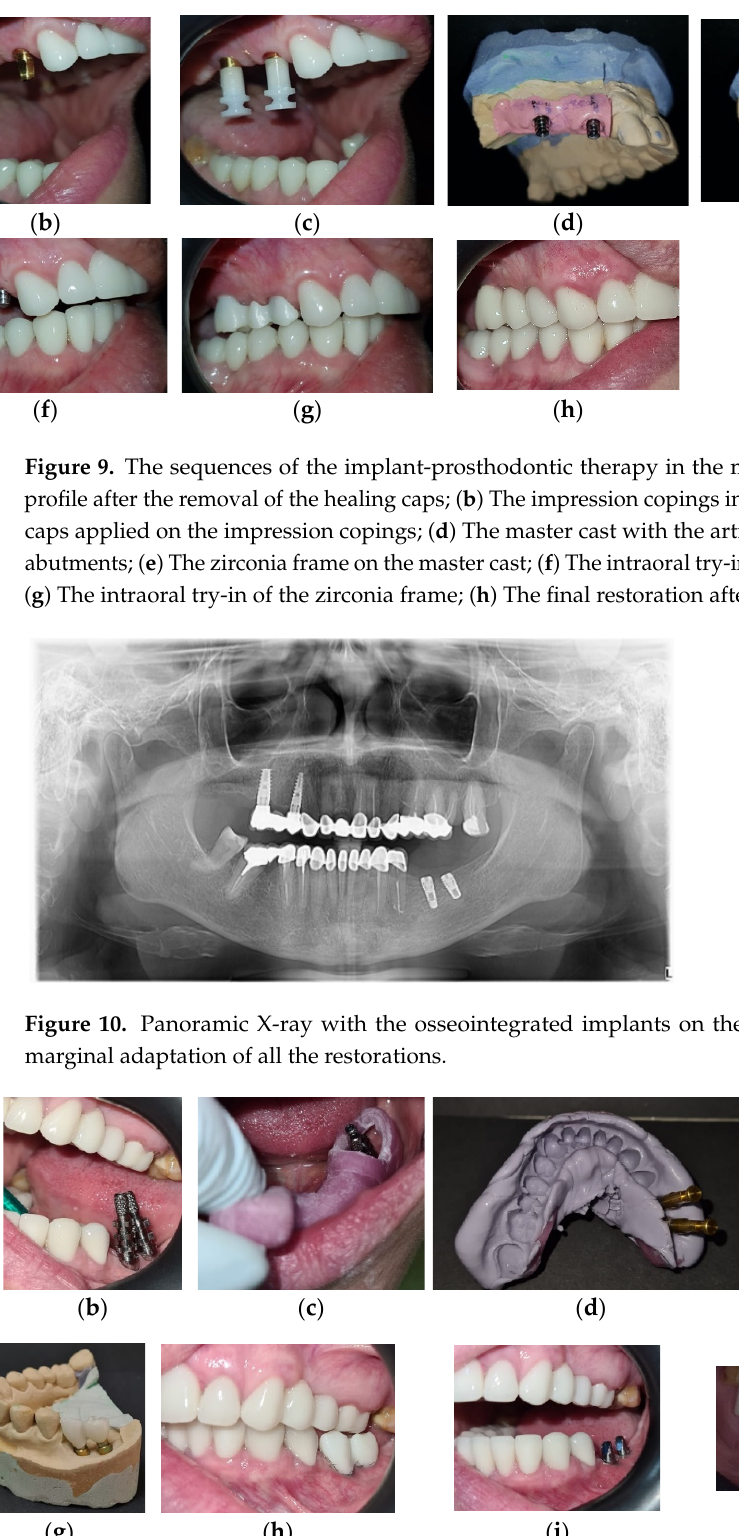
Figure 11. The sequences of the implant-prosthodontic therapy in the mandible: ( a ) The healing caps; ( b ) The impression copings in the mouth; ( c ) The try-in of the open tray; ( d ) The impression with the technical analogs ( e ) The prepared abutments and the artificial gingiva on the master cast; ( f ) The zirconia framework on the cast.; ( g ) The final restoration on the cast; ( h ) The try-in of the zirconia frame; ( i ) Closing the hole on the abutments; ( j ) The final restoration after the cementation.